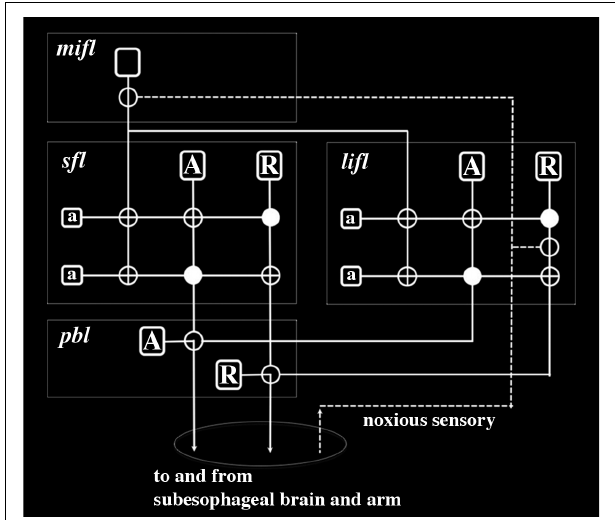
FIGURE 2 | Wiring diagram for the inferior frontal system controlling tactile discrimination behaviors in Octopus as proposed by Young (1983, 1991). This representation neglects positive sensory input associated with acceptance behaviors and instead depicts input from noxious sensory fibers from the arms that enter the inferior frontal lobes from the cerebro-brachial connective (Budelmann and Young, 1985). The stylistic circuit is drawn to highlight similarities in neural connectivity as previously described for learning and memory circuits of the superior frontal and vertical lobes (Hochner and Shomrat, 2013; Shomrat et al., 2015). Large projection neurons are depicted as unfilled rounded rectangles and in the subfrontal lobe ( sfl ), lateral inferior frontal lobe ( lifl ) and posterior buccal lobe (pbl) there are two principal types – acceptance (A) and rejection (R) – which selectively project to one another. The projection neurons associated with tactile discrimination in the median inferior frontal lobe ( mifl ) project to both the sfl and lifl where they terminate on small amacrine interneurons (a). Although this projection neuron is represented as having axon branches this is simply diagrammatic and it is most likely that there are multiple types of these neurons that have different innervation densities in the sfl and lifl . Synapses are represented as filled circles (inhibitory) or unfilled circles (excitatory). Noxious sensory fibers selectively innervate projection neurons in the lifl and mifl . Electric shock would be expected to activate R projection neurons in the lifl and depending on their state of activation by local amacrine interneurons, these R neurons would activate R projection neurons in the pbl and lead to a reject behavior. Noxious sensory fibers projecting to the mifl would cause a cascade of modulatory activity in the sfl and lifl that would robustly regulate motor behavior. With tactile discrimination training (using either or both positive and negative reinforcements) this circuitry outlined here would enable behavioral learning and memory formation that could readily increase efficacy of motor